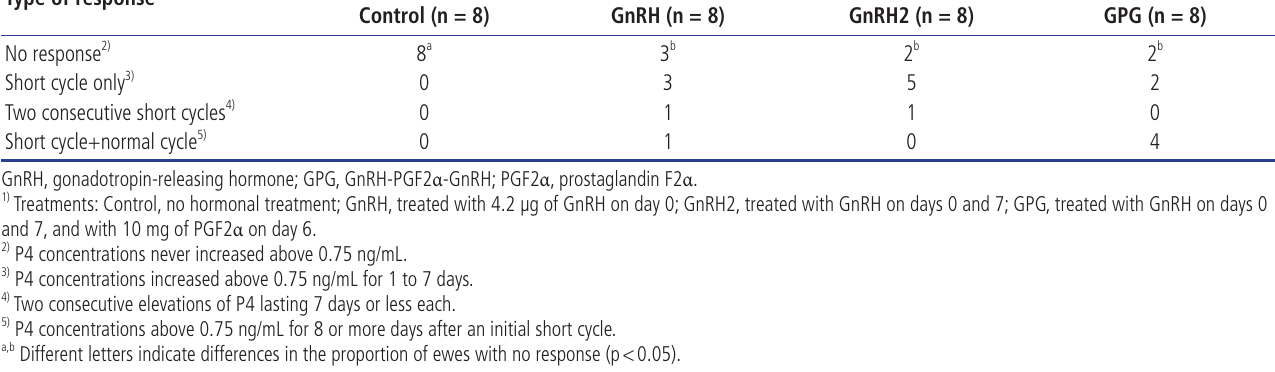
Table 1. Classification of ovarian responses after administration of different treatments to anestrous Suffolk ewes in the first experiment Type of response